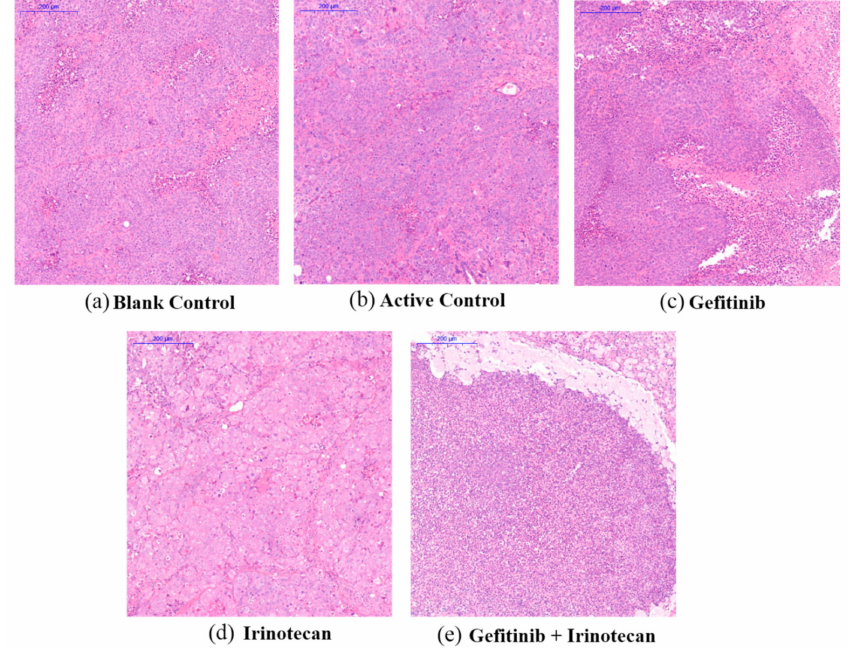
Figure 7. Effect of drug treatment on the pathological changes of transplanted tumours in nude mice, as indicated by H&E staining. ( a , b ) The solvent blank control group and the active control group of paclitaxel plus gemcitabine, respectively. ( c , d ) The single-agent gefitinib group and the single-agent irinotecan group, respectively. ( e ) Gefitinib plus irinotecan combination group. The scale bar of the subfigures is 200 µ